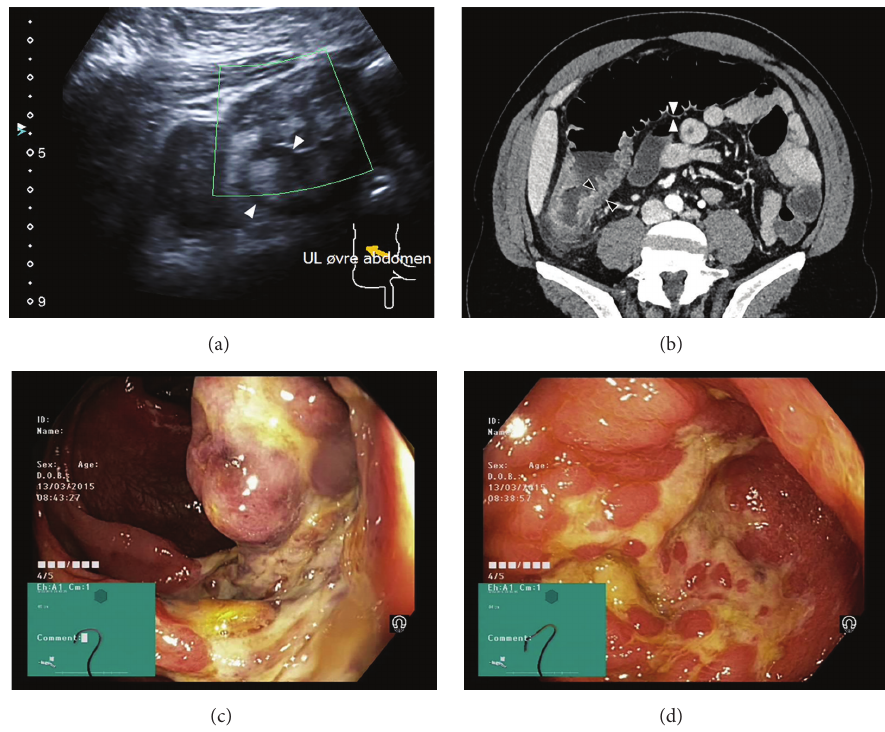
Figure 1: (a) Transabdominal ultrasound. Cecal lumen is compromised by the thickened bowel wall. (b) Computed tomography scan of the right colon. Ascending colon is thickened with intramural edema. (c) Endoscopic image from ascending colon. Image shows ischemic transformation with edema and ulcerations. (d) Endoscopic image from cecum. Circumferential alterations with fibrin-covered